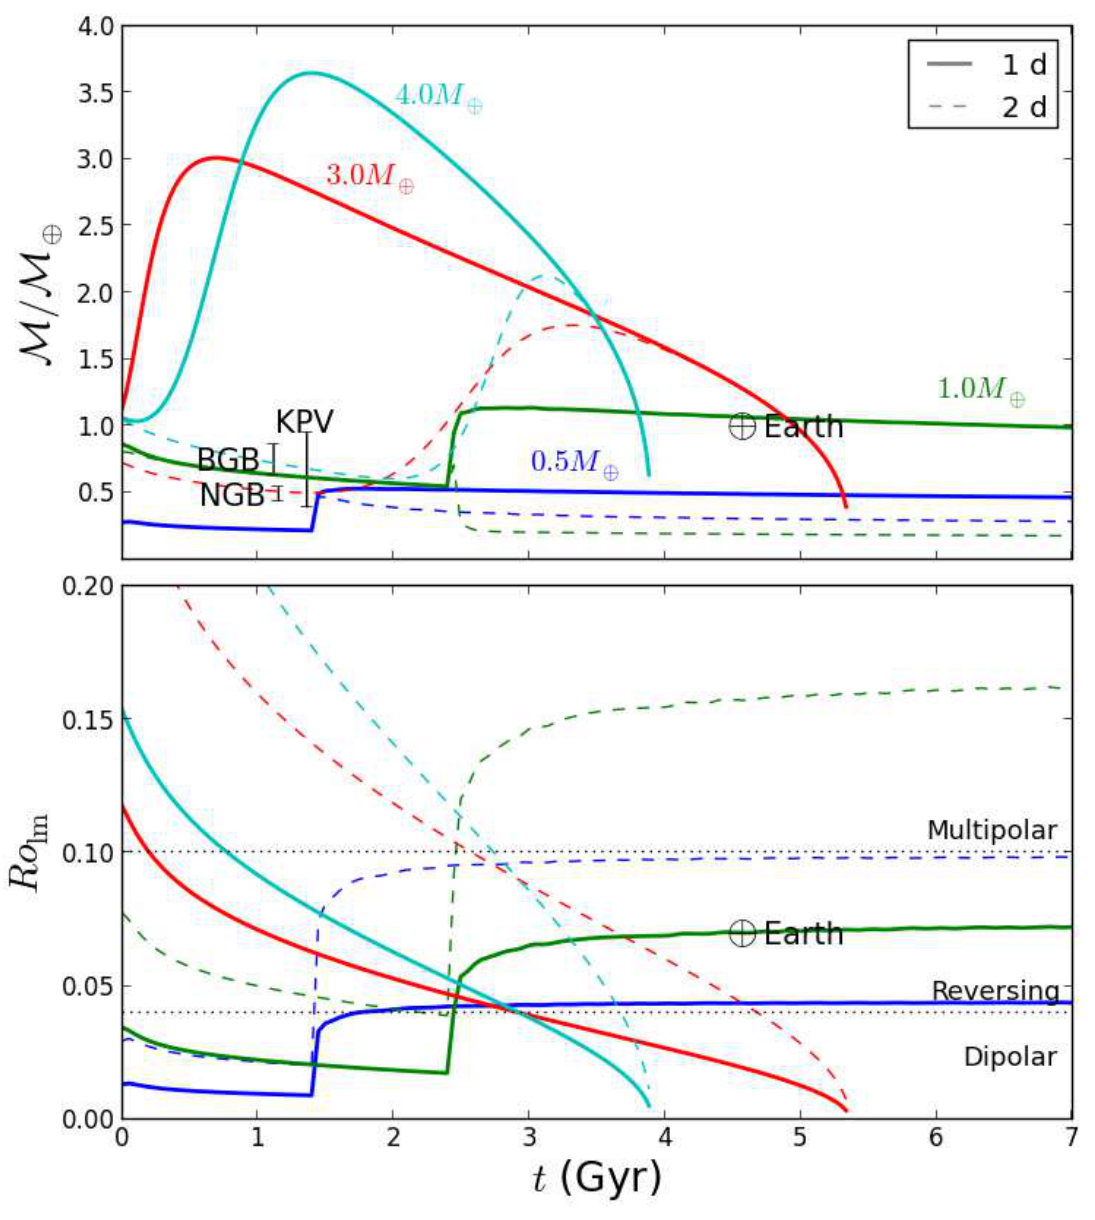
Figure 15. PMF properties predicted using the RTE and equations (93), (94) and (96) for planets masses 0.5-4.0 M ⊕ . The local Rossby num- ber (lower panel) and the maximum dipole moment (upper panel). The figure includes the present values of the geodynamo ( ⊕ ) and three measurements of paleomagnetic intensities (error bars) at 3.2 and 3.4 Gyr ago (Tarduno et al. 2010). The figure compares the magnetic properties for two periods of rotation, 1 day (solid curves) and 2 days (dashed curves). The effect of a larger period of rotation is more sig- nificant at early times in the case of massive planets ( M (cid:38) 2 M ) and at late times for lower mass planets. (Figure from ZU13, with permis- ⊕ p sion of the